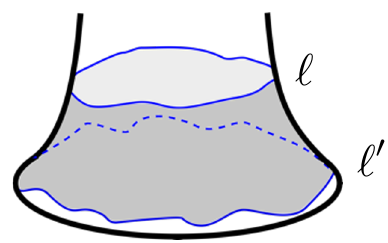
Figure 2 . The inner product h ‘ | ‘ 0 i is a sum over patches of spacetime in the asymptotic past. This patch runs between a circle with renormalized signed length ‘ 0 , on which we impose the past version of the nearly dS 2 boundary conditions (2.3), and another circle with ‘ on which we impose the future version of the nearly dS 2 boundary